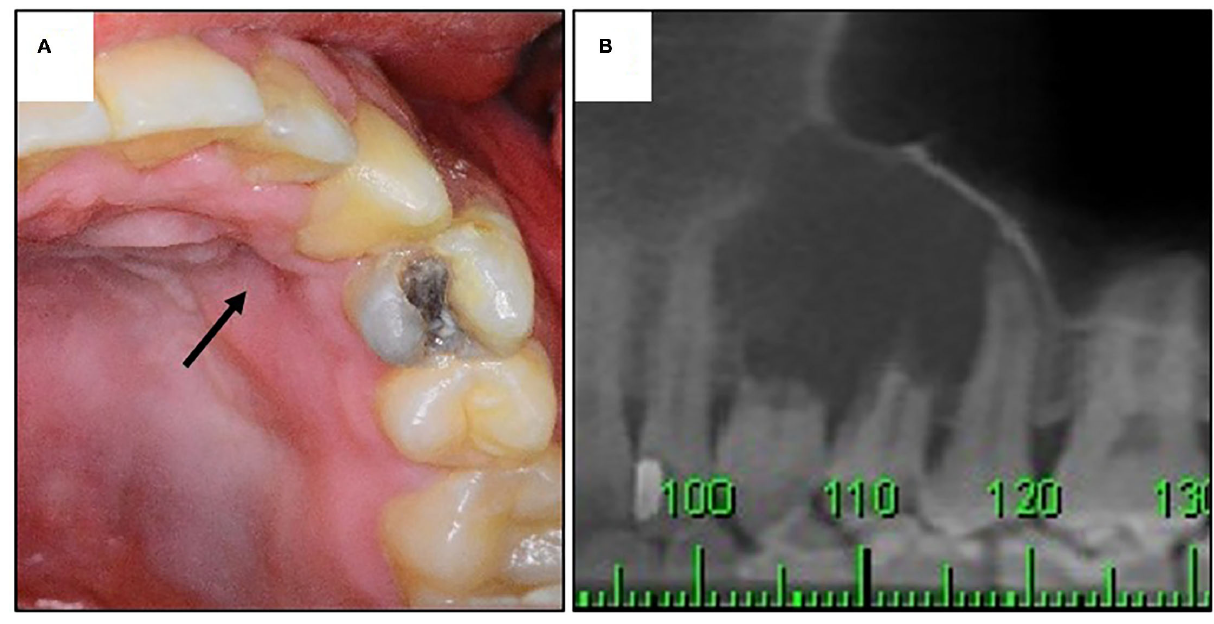
FIGURE 3 | The clinical and radiographic findings of a patient with NCLC-CEOT. (A) Clinical picture showing palatal depression (arrow); (B) prominent root resorption in cone-beam CT (CBCT)